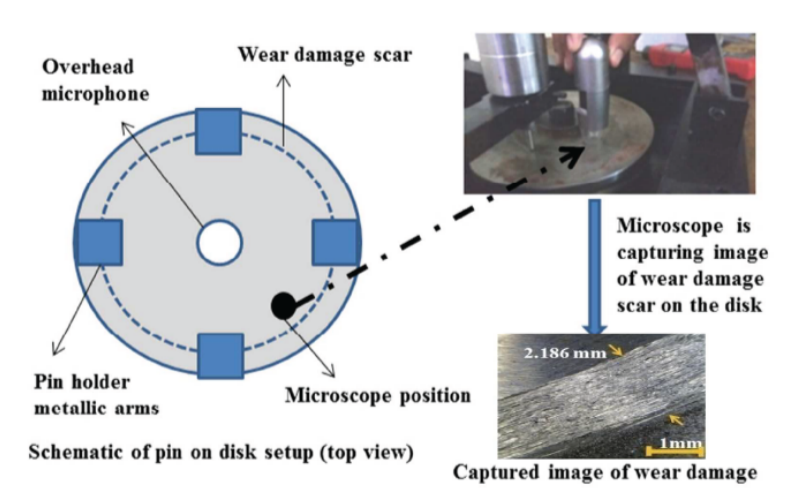
Figure 2. Portable microscope used to capture images of the disc scar (Image reused under STM Guidelines. Content rights are owned by and permission requests for further reuse are handled by SAGE Publishing, CA, USA) [1].